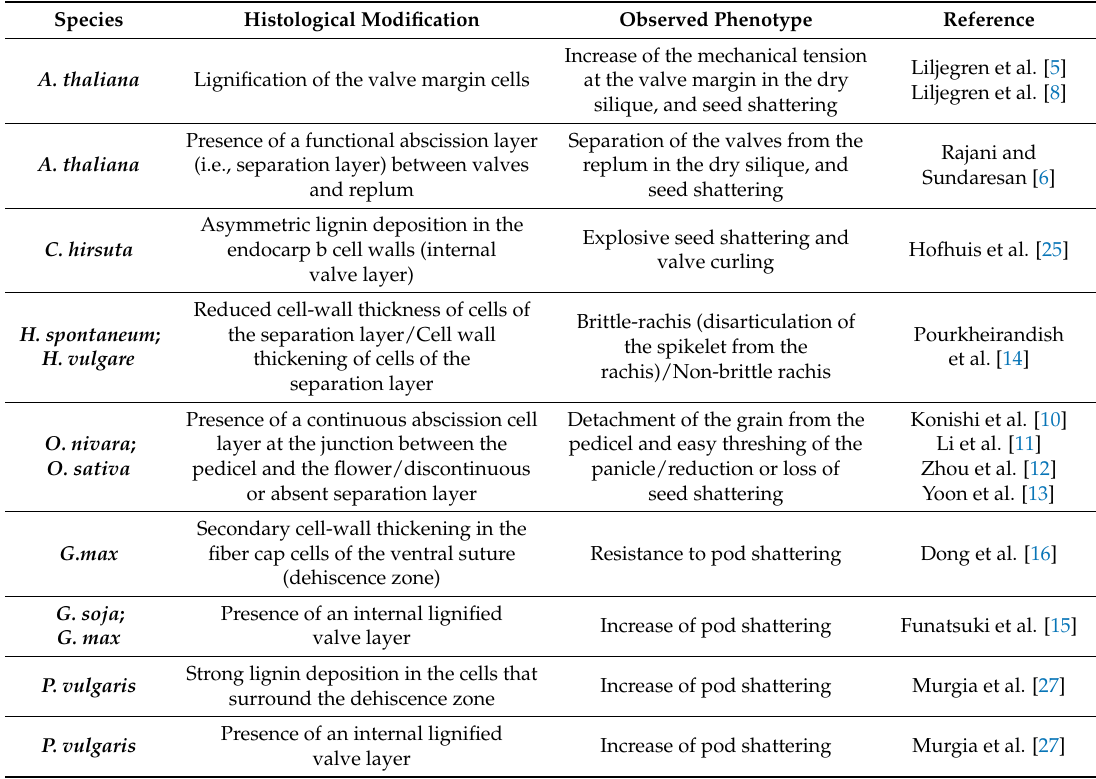
Table 1. Histological modifications associated with seed shattering in different plant species.